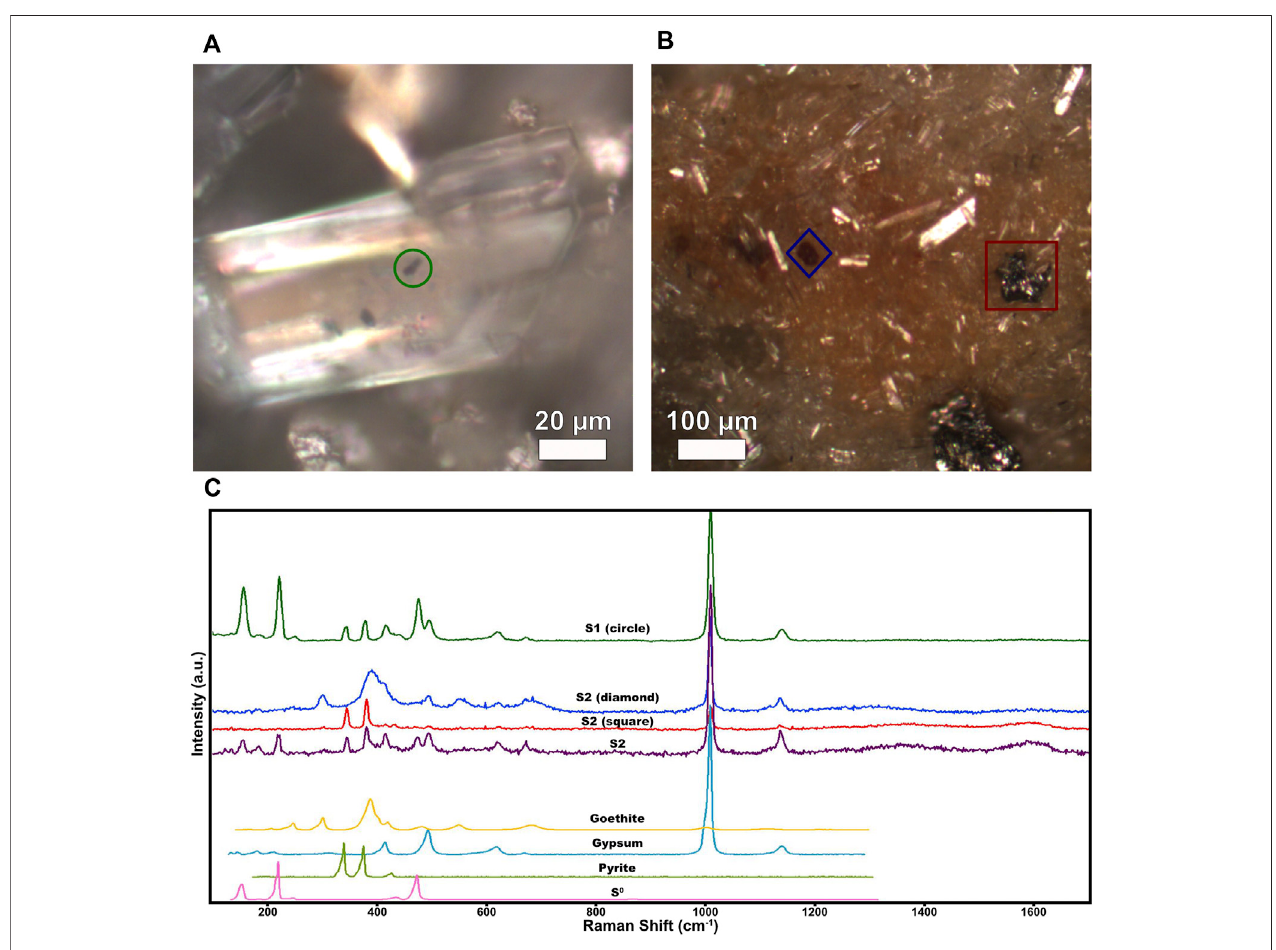
FIGURE 5 | Optical and Raman microspectroscopy of samples S1 and S2. A gypsum grain with associated dark grains of micron-sized pyrite from sample S1 is shown in (A) , while (B) shows a region of red/orange stained gypsum with iron oxide globules and larger pyrite grains within sample S2. Spectra presented in (C) show dataforapyritegrainfromS1(greencirclein A )whichbearspyriteaswellaselementalsulfur(S 0 )andalsorevealsgypsum.SpectraforaglobuleofgoethitefromS2(blue diamond in B ) and a pyrite grain from S2 with peaks for organic carbon (red box in B ) are also shown. A spectrum is presented bearing peaks for S 0 and organic carbon, which comes from micron-sized spots on the pyrite grain in the red square in (B) . Reference spectra for pyrite, S 0 , gypsum, and goethite are also shown.